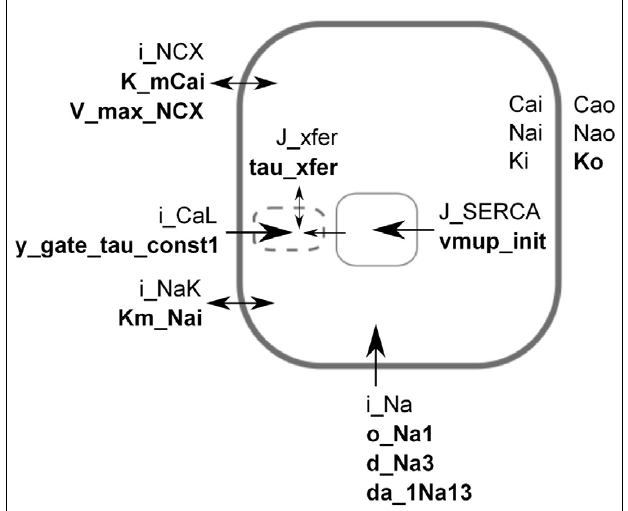
FIGURE 1 | Simplified schematic of the LNCS mouse heart cell model. For the sake of illustration, each parameter in the model was assumed to have a monogenic basis, with parameter values for genotypes aa, Aa, AA having parameter values of 50, 100, and 150% of baseline. Based on an initial sensitivity analysis, the parameters shown (bold) were selected for a full factorial simulation experiment representing 3 10 genotypes and their resulting phenotypes.The transmembrane potential is created by the difference in ion concentrations inside and outside the cell. Extracellular [Ca 2 + ], [Na + ], and [K + ] are assumed constant, whereas the intracellular concentrations are state variables. Calcium is initially sequestered (J_SERCA) into the sarcoplasmic reticulum (SR, solid box) inside the cell. In response to an electric stimulus, the fast sodium current (i_Na) sets off an action potential that in turn triggers the release of calcium (J_xfer) via “dyadic space” microdomains (dashed box) where an early L-type calcium current (i_CaL) induces release of calcium from the SR. Parameters were selected to span a range of components and roles, see Table 1 . Some components are strongly simplified in the figure, see Bondarenko et al. (2004), Li et al. (2010) for full